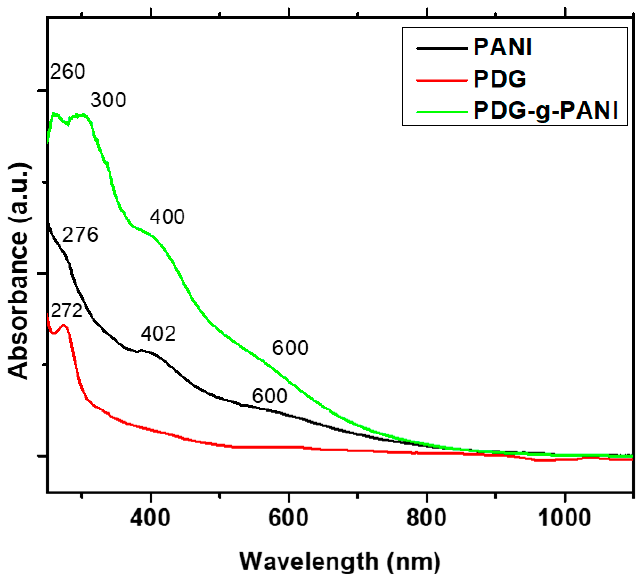
Figure 2. UV-Vis spectra of PDG, PANI, and PDG-g-PANI.